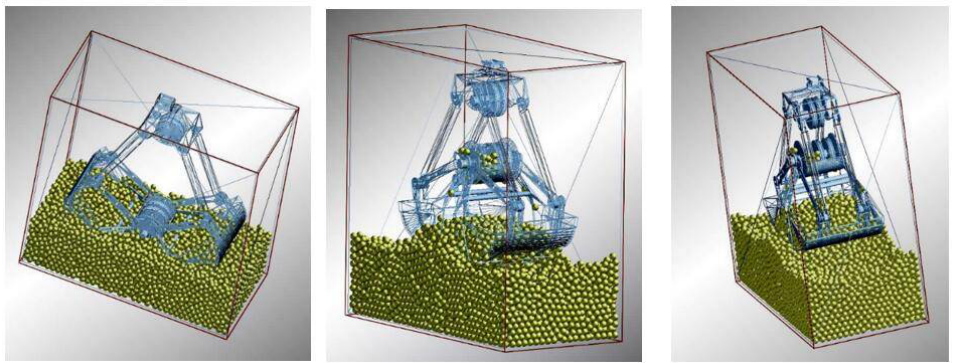
Figure 15. Flat digging process of grab.